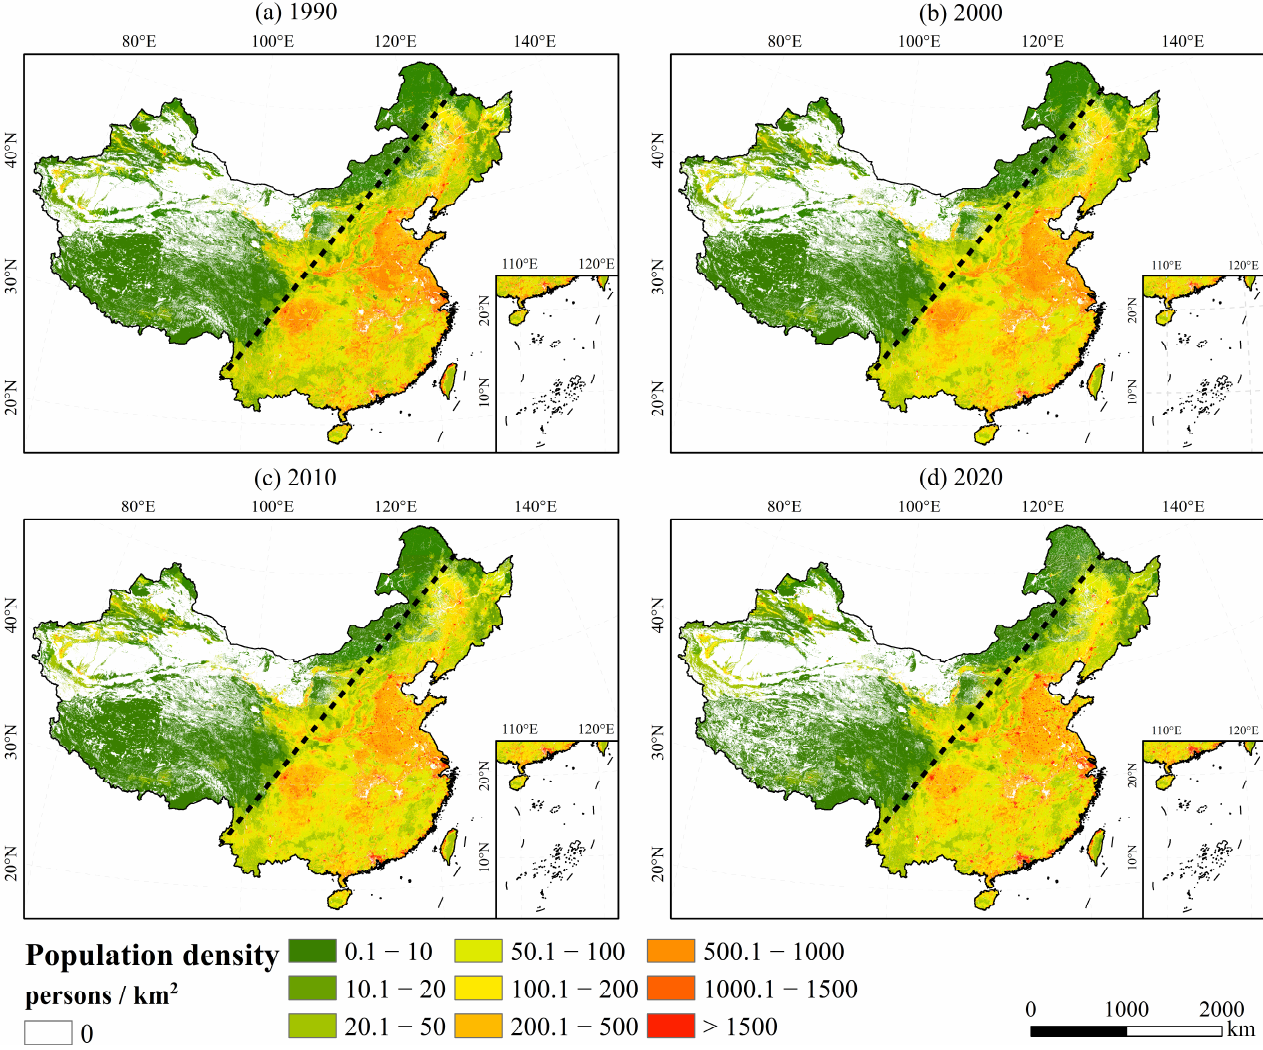
Figure 8. Population densities in 1990, 2000, 2010, and 2020.